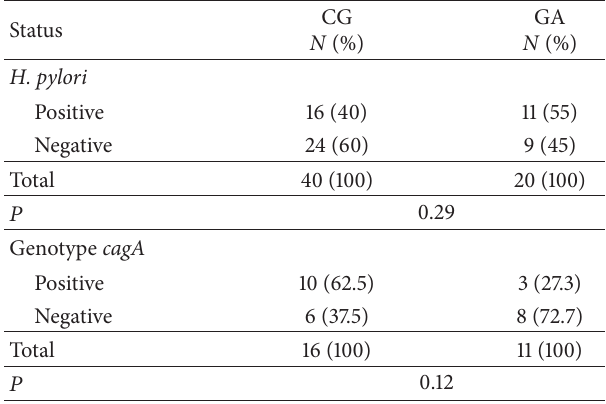
Table 2: Distribution of infection by H. pylori and cagA strains into chronic gastritis (CG) and gastric adenocarcinoma (GA)